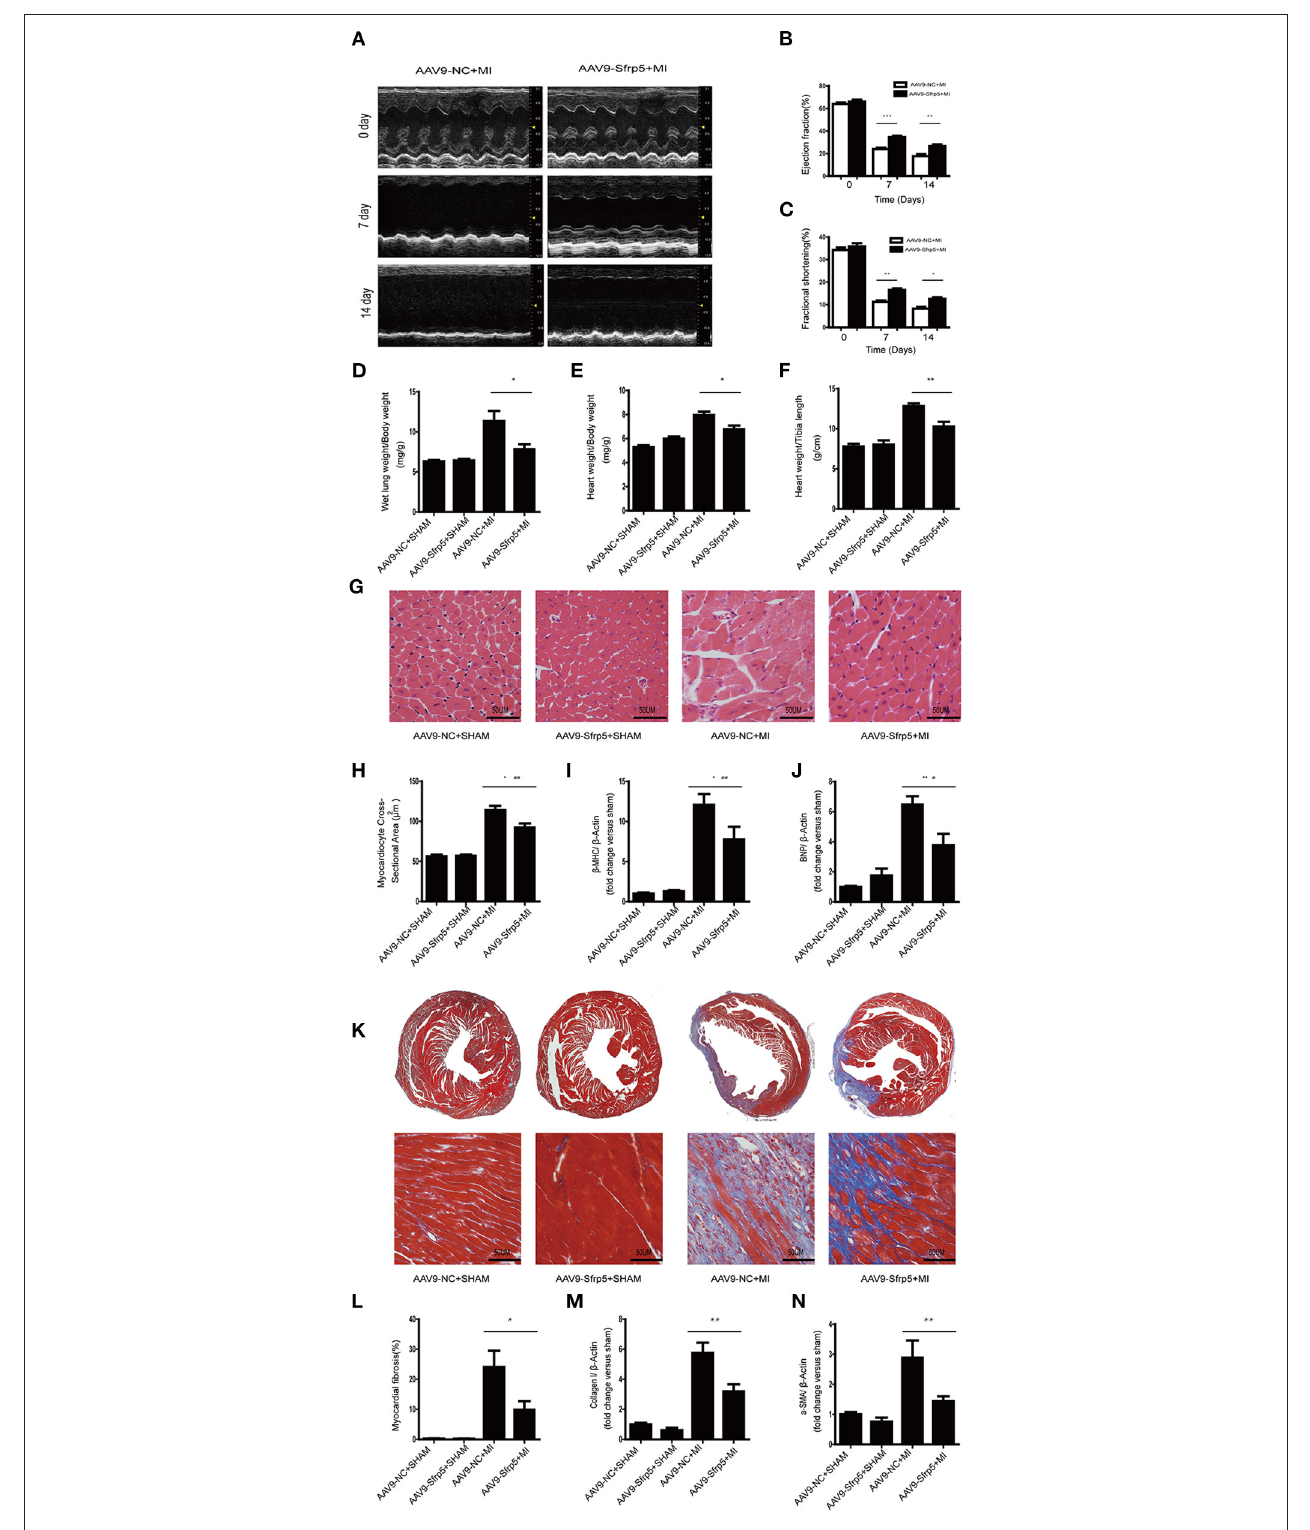
FIGURE 3 | Sfrp5 improved cardiac function and alleviated cardiac remodeling at 2 weeks after MI. (A) Echocardiography of mice at 2 weeks post infarction ( n = 9 per group). (B) LVEF analysis before and after MI. (C) LVFS analysis before and after MI. (D) Ratio of LW to BW ( n = 6 per group). (E) Ratio of HW to BW (n = 6